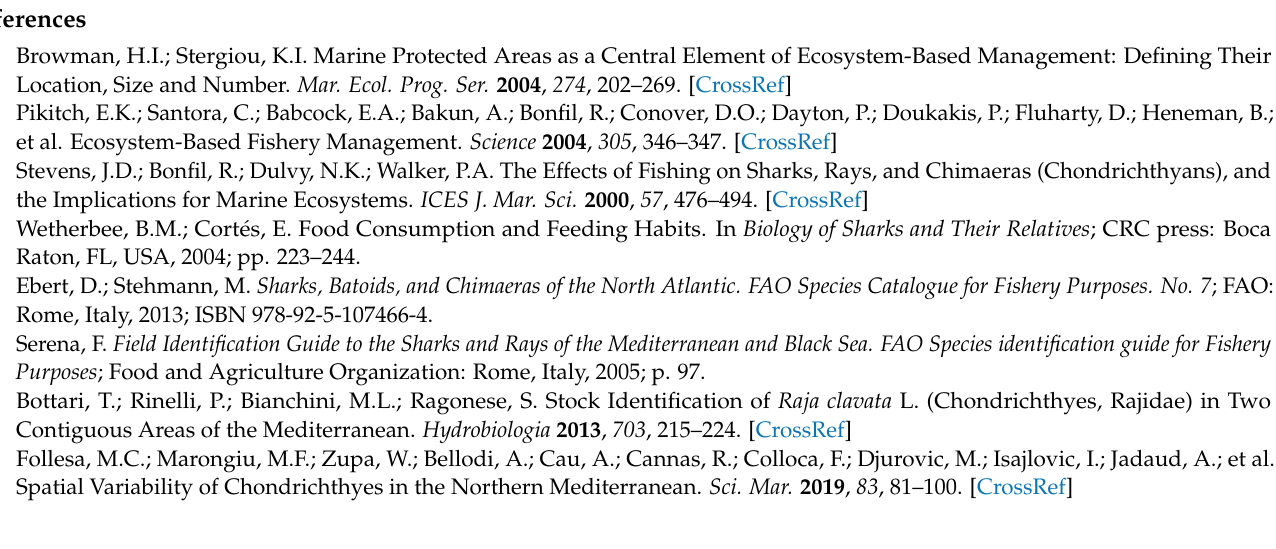
Table S2: Filtered worldwide Elasmobranchii sequences IDs; Table S3: Estimates of genetic diversity for Elasmobranchii